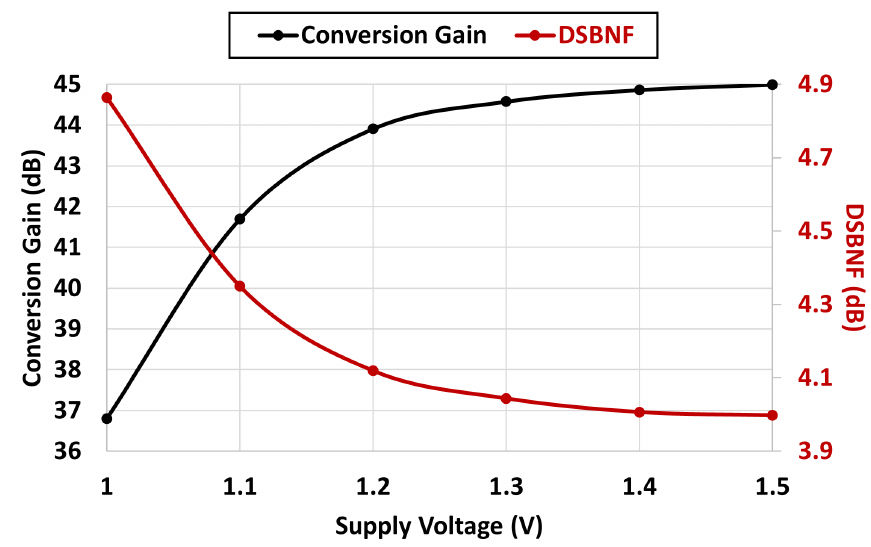
Figure 11. The NF and conversion gain versus supply variations.